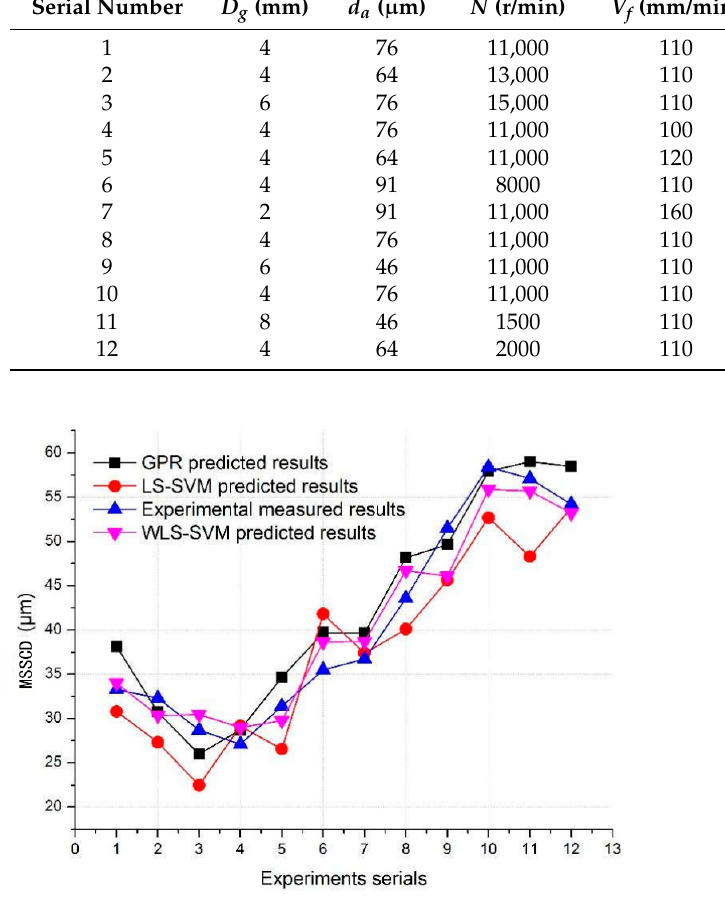
Figure 8. Comparison between WLS-SVM, LS-SVM, and GPR predictions and experimental results.